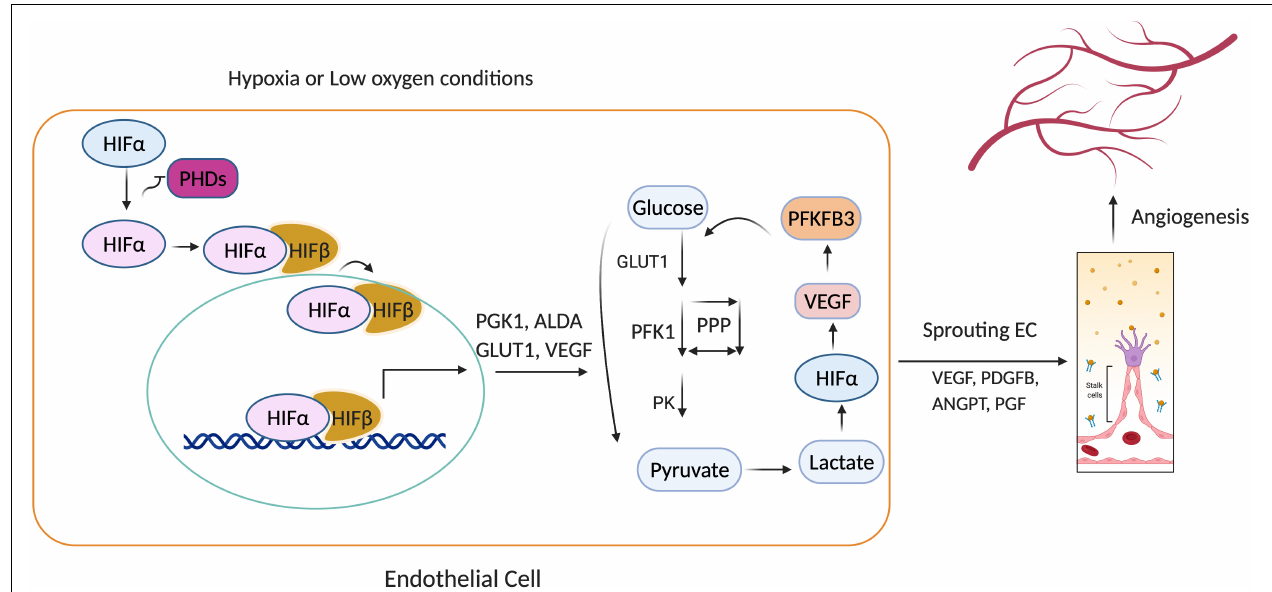
FIGURE 2 | Hypoxia-inducible factor 1 α (HIF1 α )-mediated endothelial cell (EC) angiogenesis. Under hypoxia, prolyl hydroxylases (PHD1-3) cannot catalyze the hydroxylation of HIF α subunits, so HIF α avoids ubiquitin-mediated proteasomal degradation and translocates into the nucleus, where it activates genes that regulate glycolysis (PGK1, GLUT1, ALDA) and angiogenesis (VEGF, PDGFB, ANGPT). Thus, low oxygen availability causes HIF1 α to accumulate, which promotes glycolytic flux, EC proliferation, and the sprouting of new capillaries.